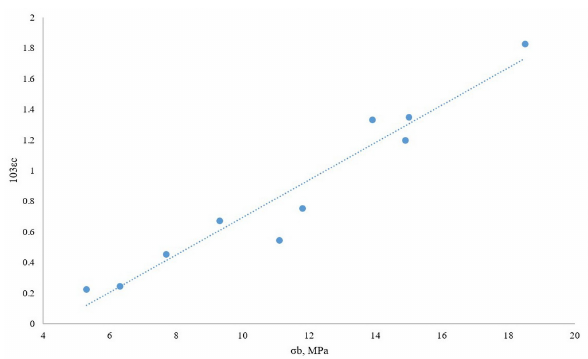
Figure 3: Dependence ϵ c from σ